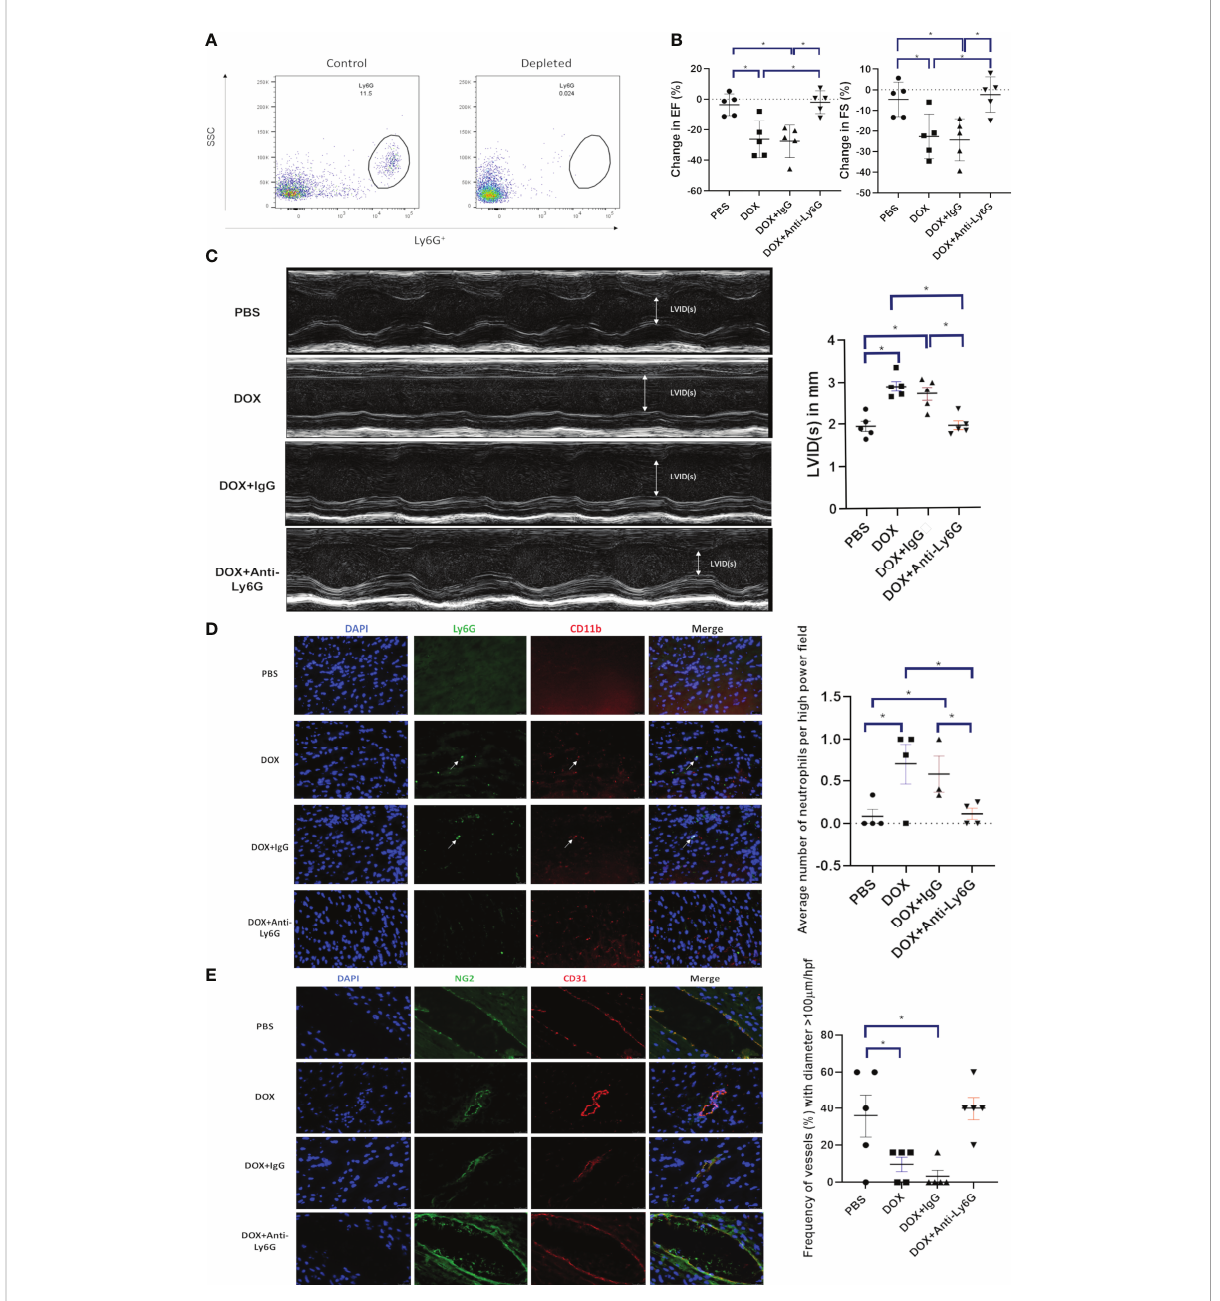
FIGURE 2 Effect of neutrophil depletion on heart function and vascular morphology 24 h after therapy. (A) Depletion of neutrophils was quanti fi ed by fl ow cytometry as described in Figure 1 b and c; (B) In mice with control phosphate-buffered saline(PBS), doxorubicin(DOX), DOX plus control IgG, or DOX plus anti-Ly6G antibody, ejection fraction (EF), fractional shortening (FS) were quanti fi ed; (C) Left ventricular internal dimension in systole (LVID(s)) were quanti fi ed; (D) Representative images of neutrophils (CD11b + Ly6G + ) in the hearts of mice treated with control phosphate-buffered saline(PBS), doxorubicin(DOX), DOX plus control IgG, or DOX plus anti-Ly6G; (E) Representative images of NG2 + and CD31 + vessels. Results are presented as mean ± SEM, n = 5 each, * p < 0.05, one-way ANOVA analysis with Tukey comparison was used to compare the